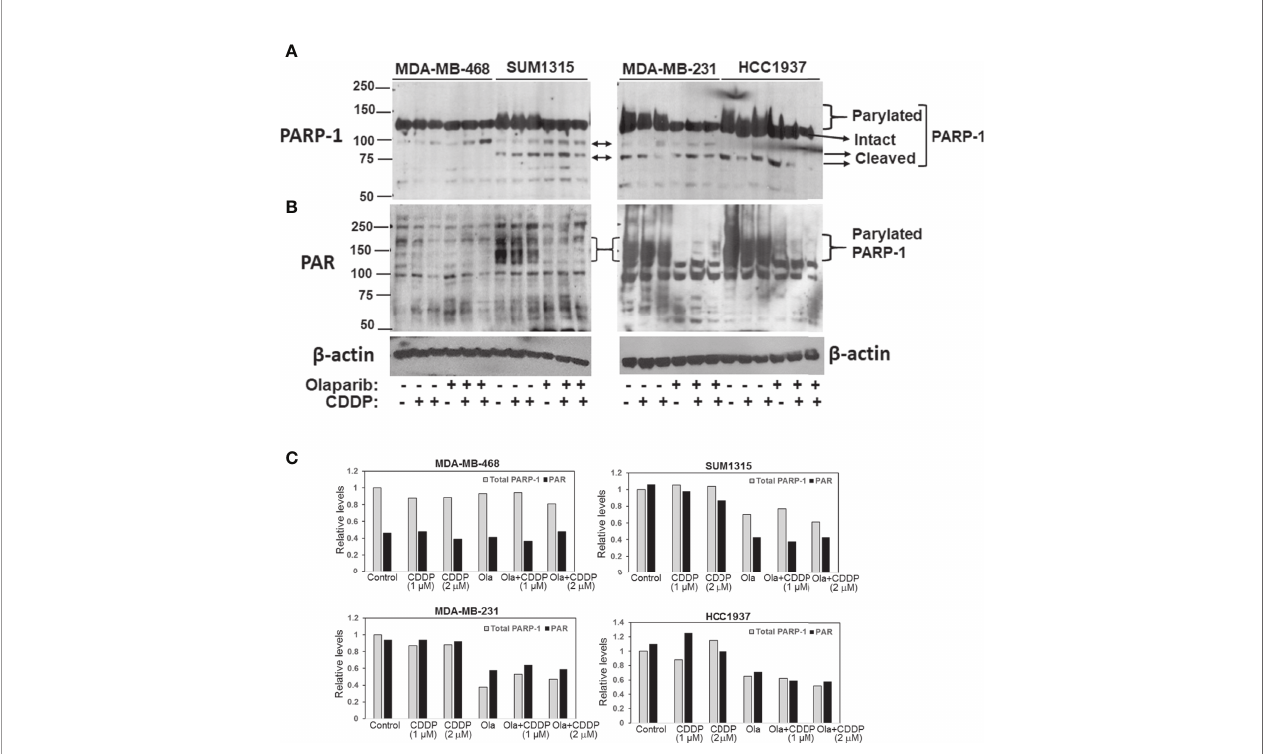
FIGURE 2 | Analysis of TNBC intrinsic PARP-1 activities and regulation by olaparib and cisplatin (CDDP). Western blot analysis of PARP-1 (A) and PAR (B) in whole cell lysates of MDA-MB-468, SUM1315, MDA-MB-231 and HCC1937 cells treated overnight singly with olaparib or CDDP, or their combination. Cells were treated with 3 m M (MDA-MB-468), 8 m M (SUM1315, MDA-MB-231) or 10 m M (HCC1937) olaparib, 1 or 2 m M (MDA-MB-468), 2 or 4 m M (SUM1315, MDA-MB-231), or 4 and 8 m M (HCC1937) CDDP, or their combination. (C) Quantitation of relative total PARP-1 (native and PARylated) and PAR